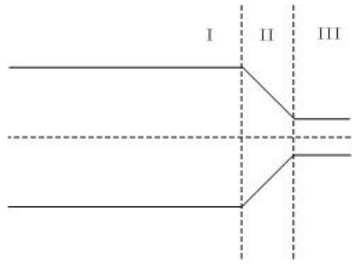
Figure 1. Schematic diagram of the internal geometric region of the extrusion liquefier.